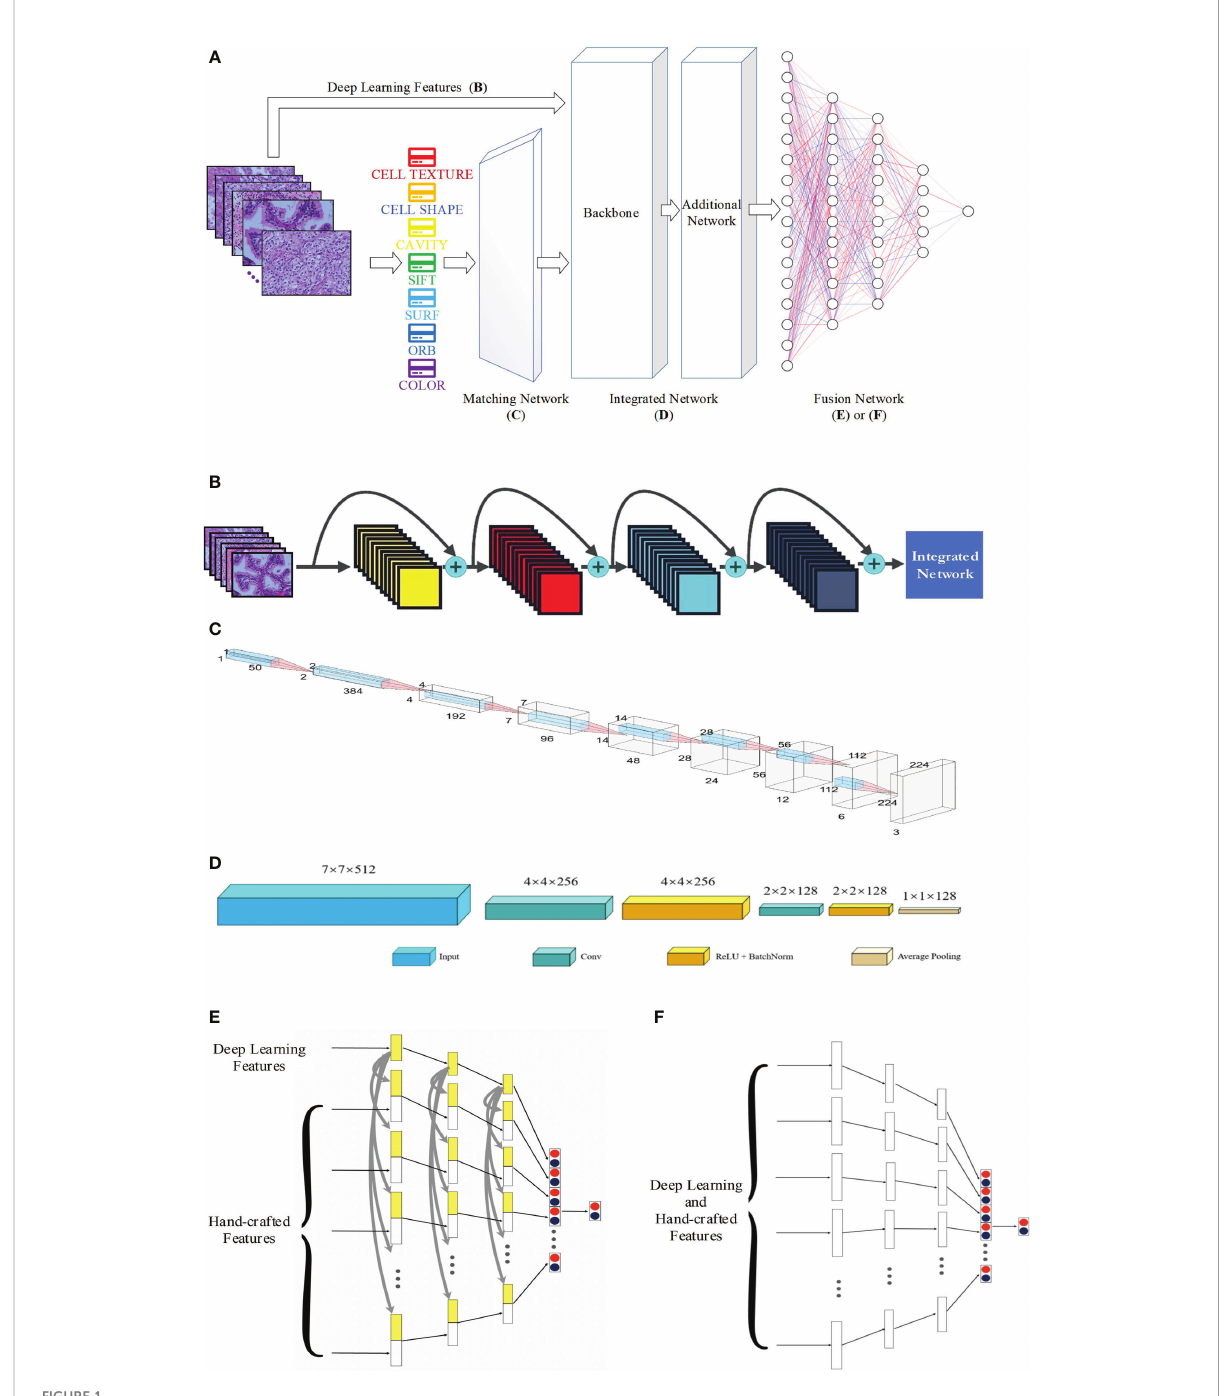
FIGURE 1 Proposed network for pathology image classi fi cation: (A) the whole work fl ow; (B) DL feature extraction; (C) architecture of the matching network; (D) architecture of the integrated network; (E) and (F) for architecture of the fusion network with and without